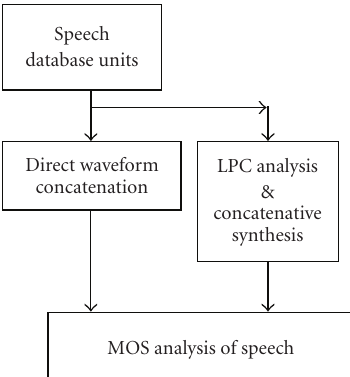
Figure 1: Overview of the TTS